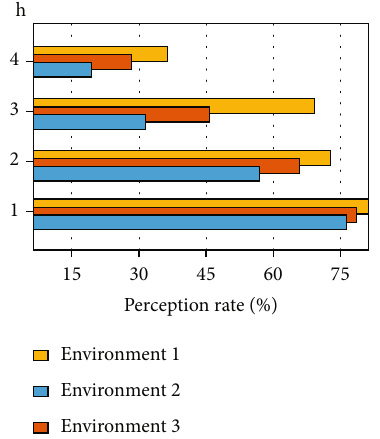
Figure 9: UAV perceived target obstacle ratio